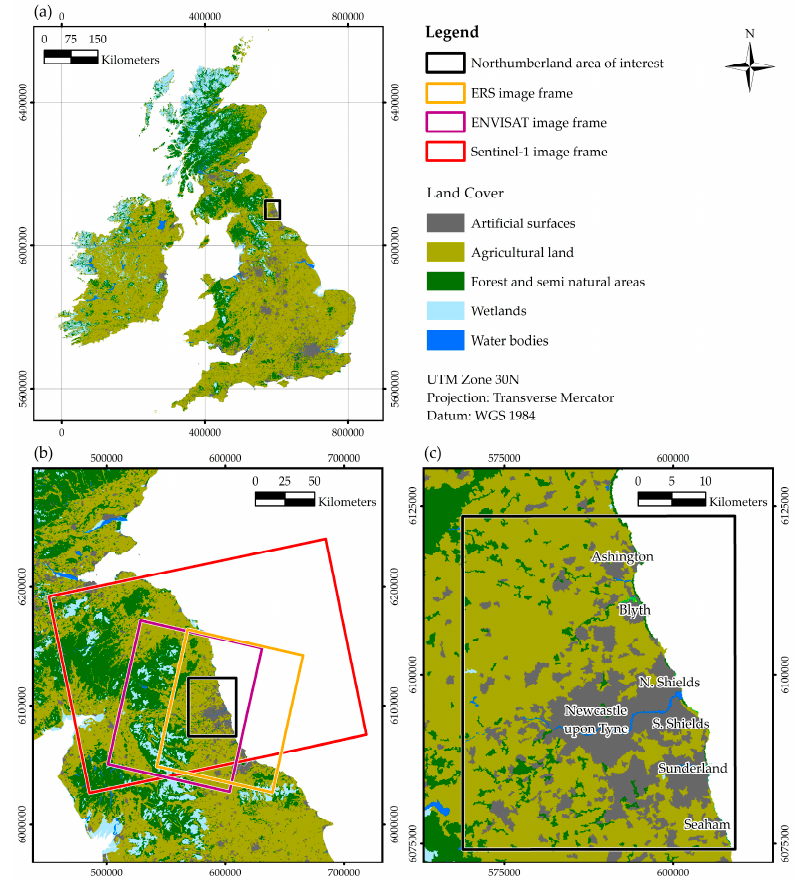
Figure 1. A land cover classification of the United Kingdom and Ireland taken from the 2012 CORINE (Co-ordinated Information on the Environment) Land Cover inventory [23]: ( a ) A map detailing the location of the Northumberland area of interest (AOI) within the United Kingdom; ( b ) Footprints of the ERS, ENVISAT and Sentinel-1 image frames; ( c ) The AOI with major towns and cities labelled. Copyright holder: European Environment Agency